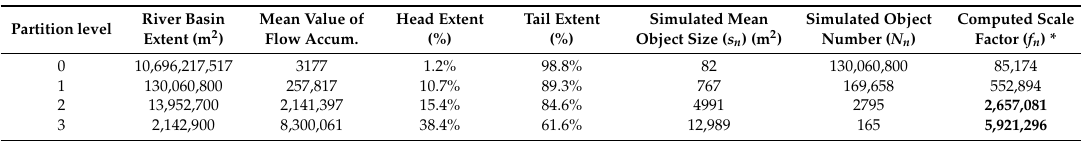
Table 7. Partial and final outputs for flow accumulation in the Pinios river basin; 0-partition level corresponds to the original flow accumulation surface.